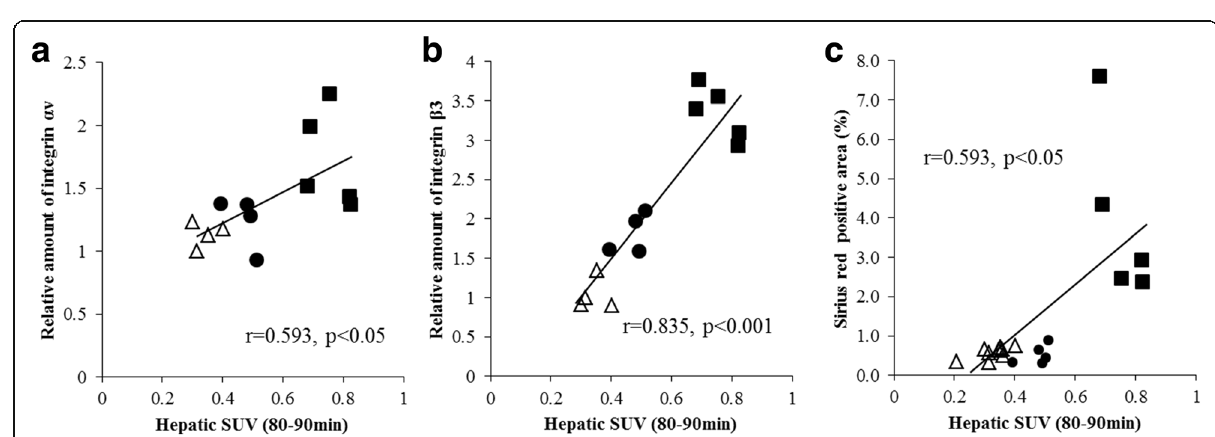
Fig. 8 Correlation between hepatic 18 F-FPP-RGD 2 uptake and integrin α v ( a ), β 3 ( b ) subunits, and Sirius red-positive area ( c ). Correlations were analyzed using Spearman ’ s ranked correlation test. white triangle, control; black circle, CDAHFD 3 weeks; black square,CDAHFD 8